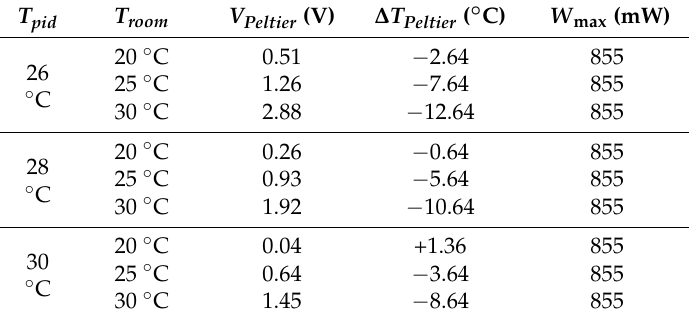
Table 2. Sensor operating domain for a thermostat temperature ( T pid ) range of 26–30 ◦ C and at an ambient temperature ( T room ) of 20–30 ◦ C. The table shows the voltage V Peltier across the cooling thermopile required to produce the temperature decrease ∆ T Peltier , and the maximum measurable power ( W max ) for each example. T